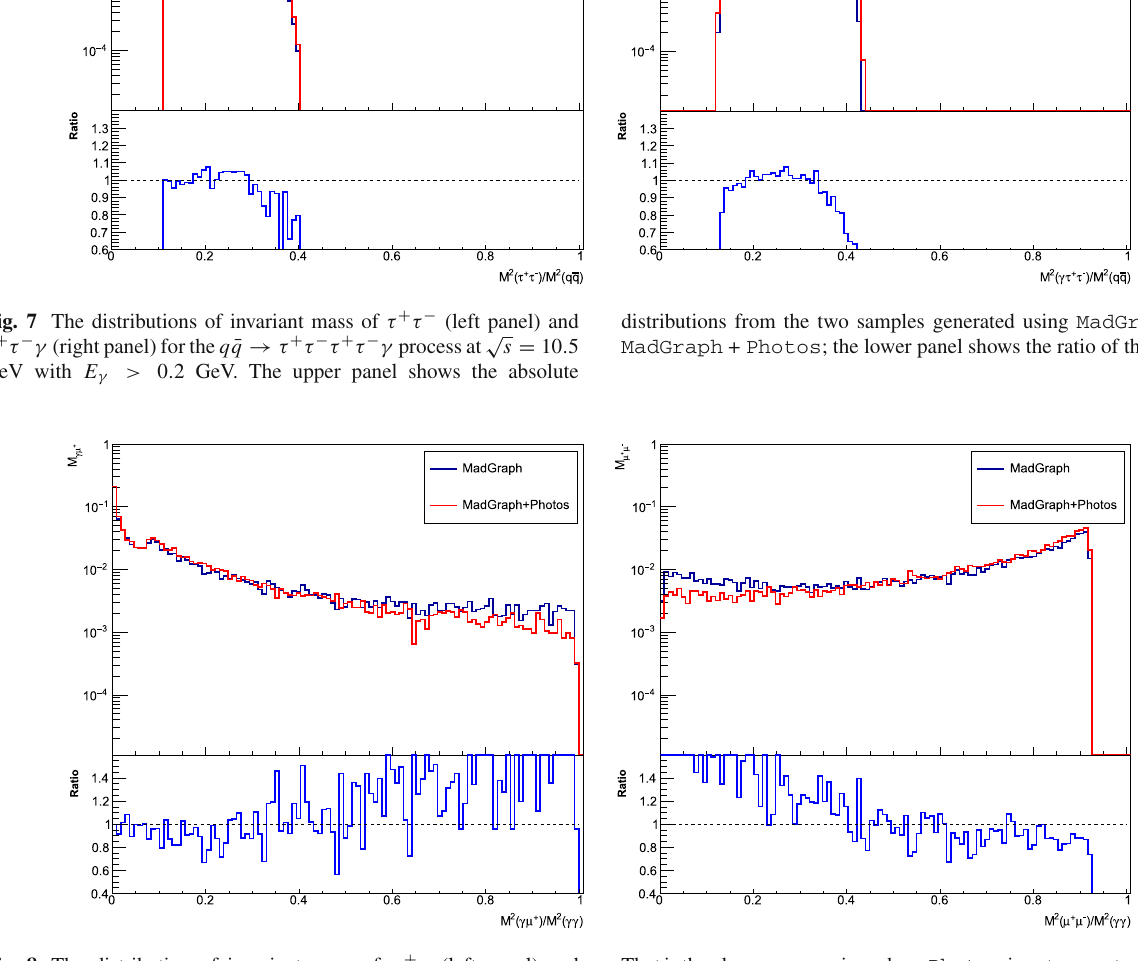
That is the phase space region where Photos is not guaranteed to work well due to its design. Still, only for hardest emission sub-region which is scarcely populated, differences may approach 70%. That should be expected, as the kernel in Photos is not improved with matrix element for this